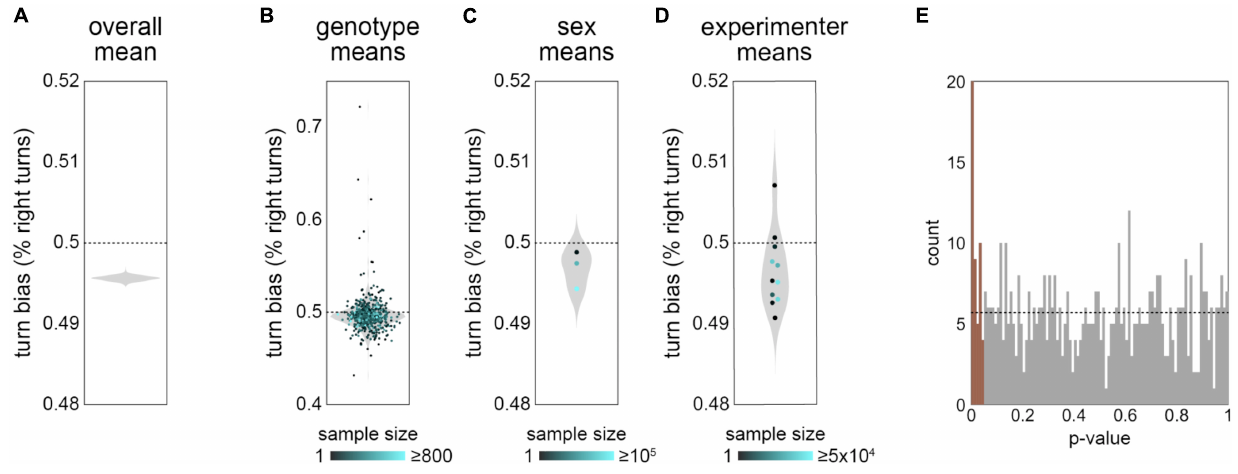
FIGURE 3 | Mean turn bias appears slightly asymmetrical— (A) Violin plot of estimate distribution for the mean of turn bias across the grand data set, exhibiting an apparent slight left-bias of 49.6%. Violin is a kernel density estimate (KDE) of this statistic from 1,000 bootstrap replicates. (B) Mean turn bias for each genotype (points). Violin is the KDE of genotype means. Point color indicates the number of flies recorded for that genotype. (C) As in panel (B) , but with flies grouped by sex. The three points correspond, from top to bottom, to males only, females only and mixed sex. (D) As in panel (B) , but with flies grouped by experimenter. Note: the groups with the highest apparent right-bias have low sample sizes. (E) Histogram of p-values from a linear model with each genotype as a predictor. Brown bars represent effects significant at p < 0.05. Dotted line indicates the expected distribution under the null model. Data from all 183,496 flies were used in these analyses.